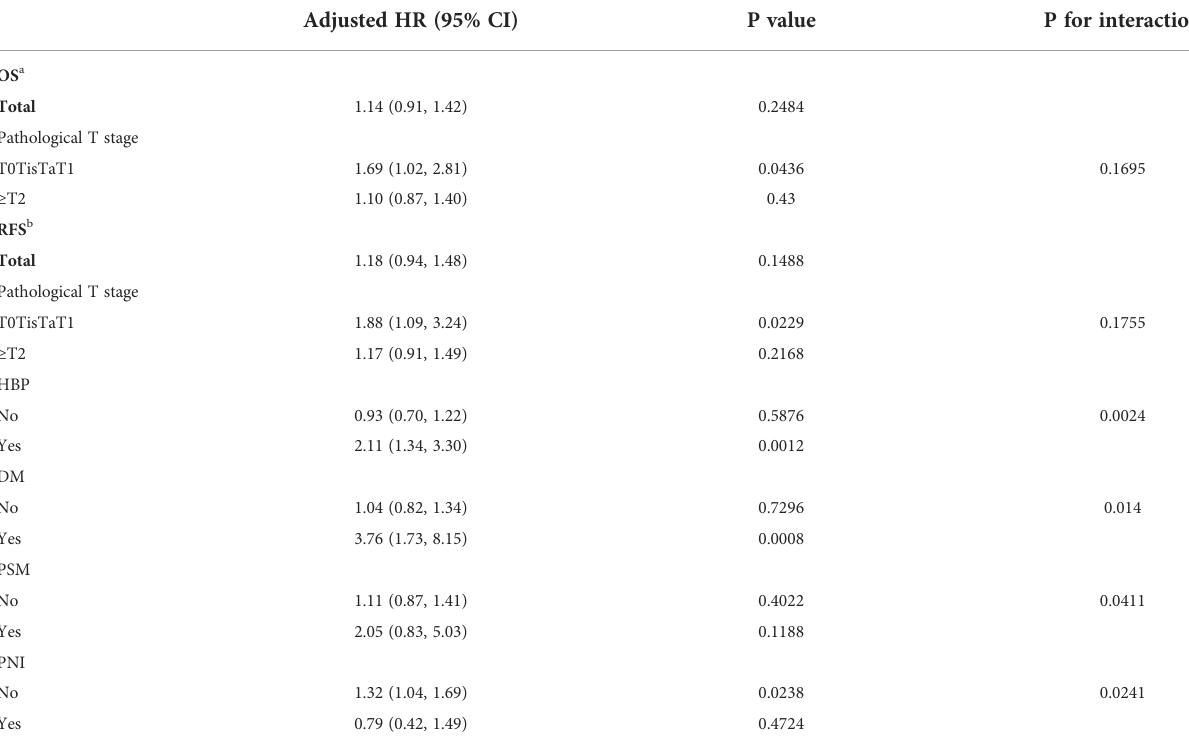
TABLE 3 Multivariate Cox regression analyses estimating the in fl uence of SII on overall survival (OS) and recurrence-free survival